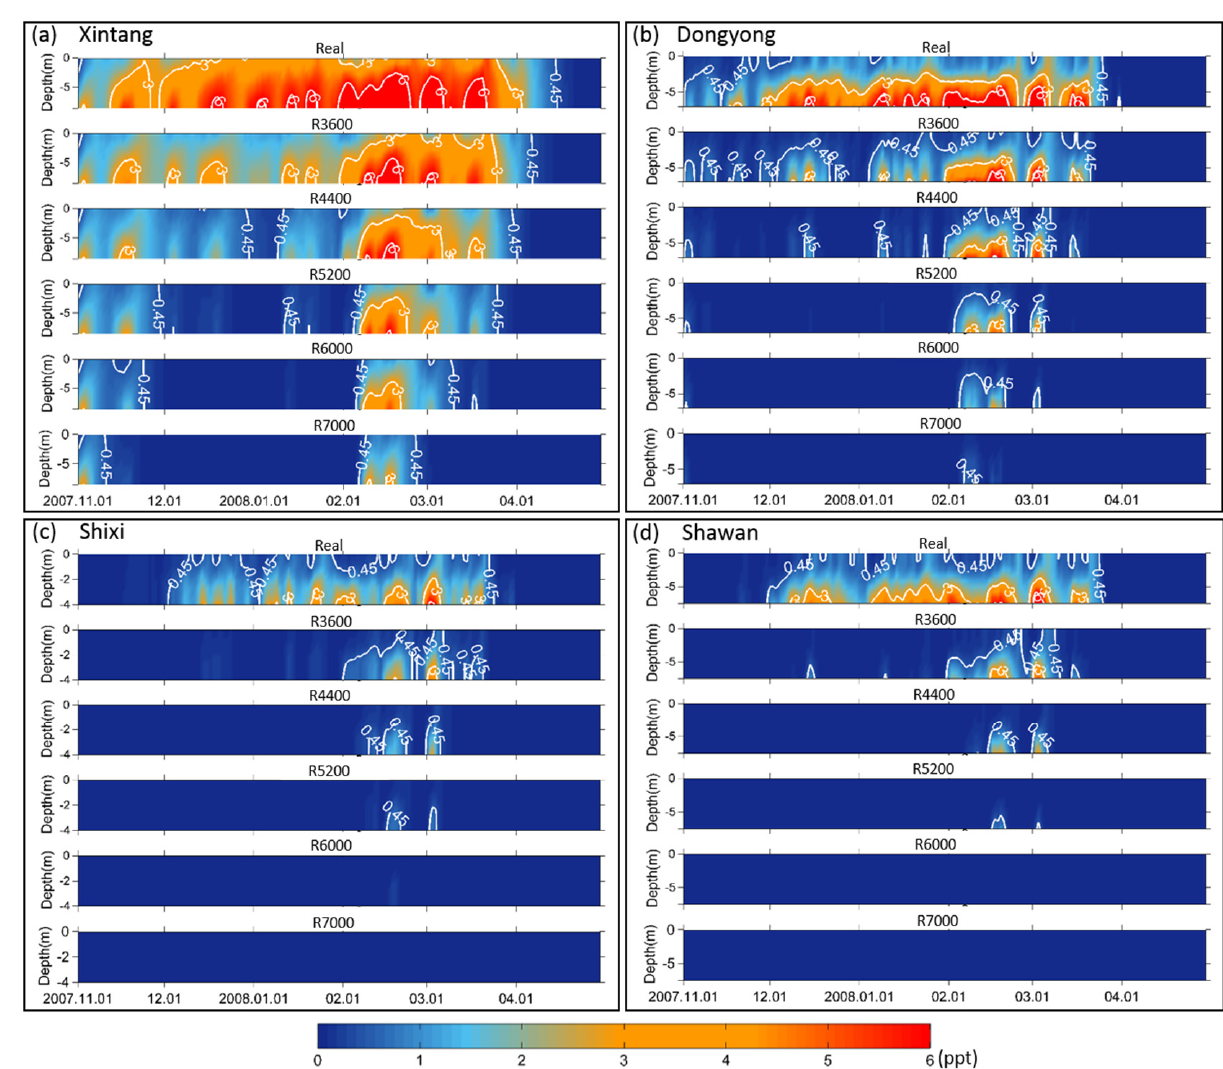
Figure 6. Responses of salinity to the flow modulation under the 100-cm sea-level-rise scenario. ( a ) Xintang; ( b ) Dongyong; ( c ) Shixi; ( d ) Shawan. Results from the real flow and each flow-modulation case are presented. The cases with river flows of 3600, 4400, 5200, 6000, and 7000 m 3 /s are referred to as R3600, R4400, R5200, R6000, and R7000,